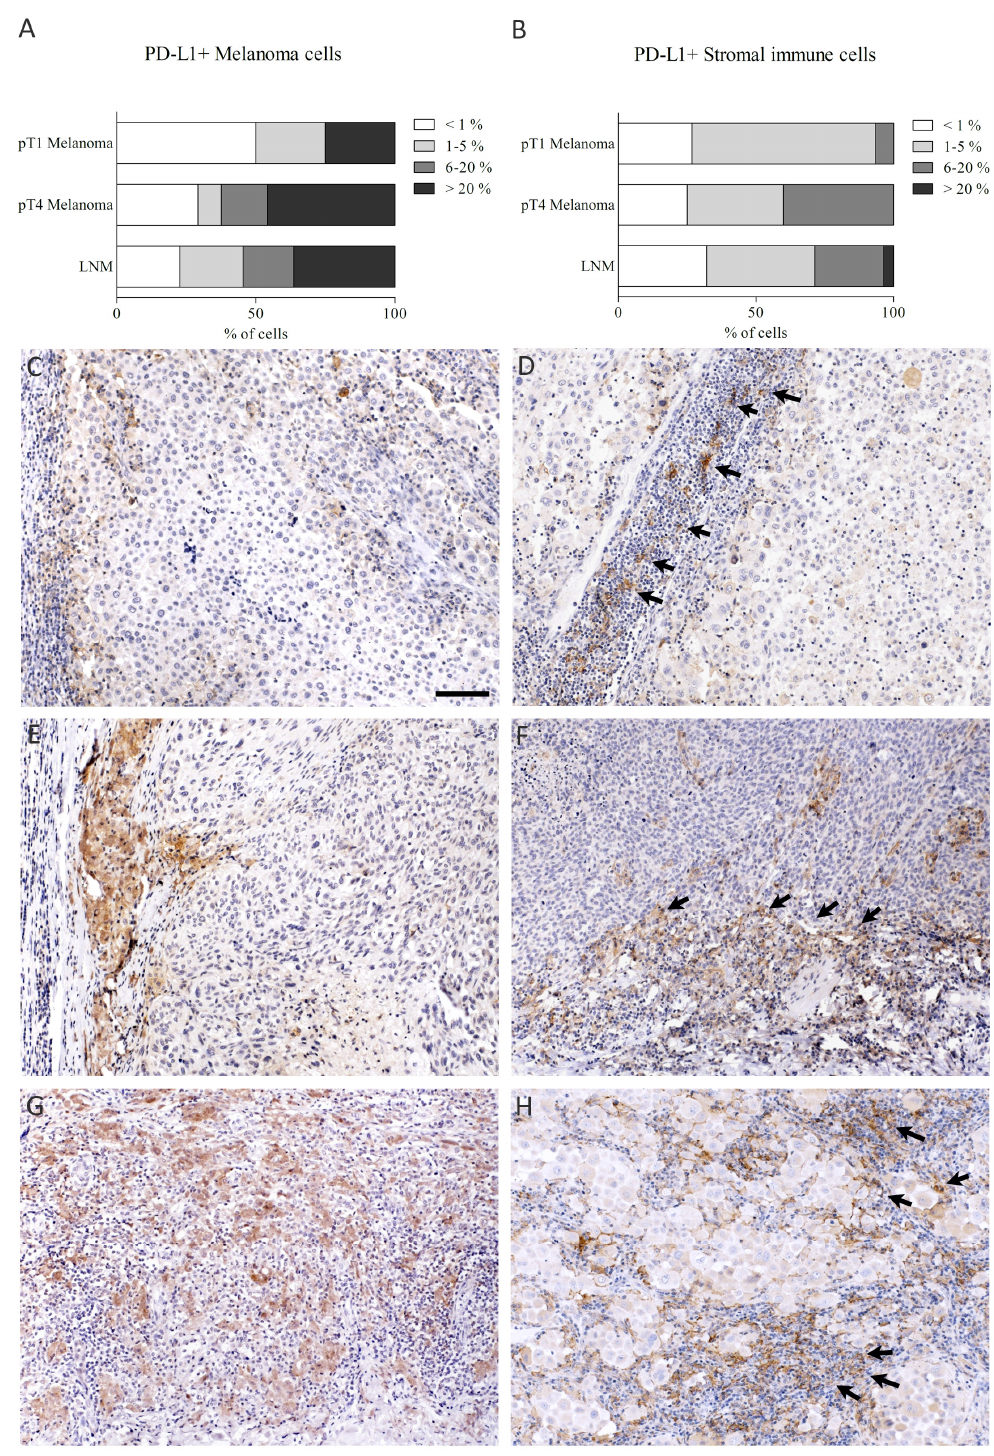
Figure 4. PD-L1 expression in melanoma cells ( A ) and stromal immune cells ( B ) in malignant lesions, and representative immunohistochemical stainings of PD-L1 ( C – H ), positive staining shown in brown and counterstained nuclei in blue). PD-L1 expression in melanoma cells and stromal immune cells was evaluated with four-level scoring system. PD-L1 expression 1–5% in tumor and stromal cells in ( C ) and ( D ), 6–20% in ( E , F ), and >20% in ( G , H ), respectively. Black arrows in ( D , F ) and ( H ) mark the PD-L1+ stromal immune cells. Scale bar 100 µ m ( × 100 magnification). pT = pathological tumor stage, LNM = lymph node metastasis.